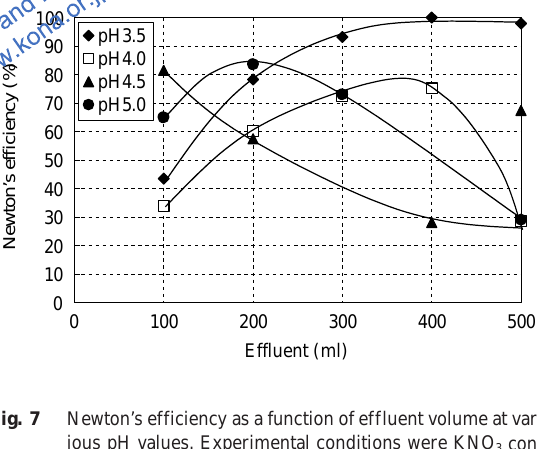
Fig. 7 Newton’s efficiency as a function of effluent volume at var- ious pH values. Experimental conditions were KNO 3 con- centration of 10mM, silica concentration of 26mg/L, and superficial velocity of 1.7mm/s.